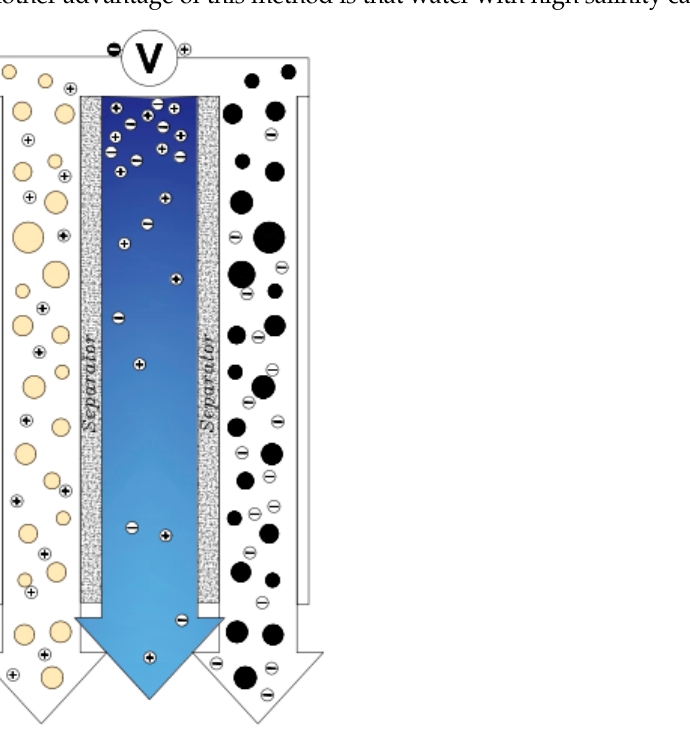
Figure 7. Wire electrode in a CDI cell.